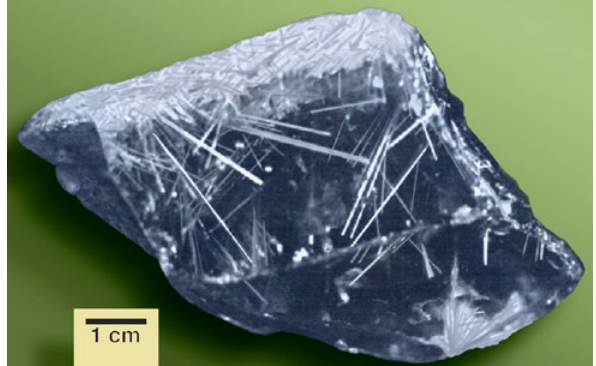
Figure 27. Long slender ‘needles’ of rutile develop in the gelatinous polymeric precursor of a large single crystal of vein quartz. Growth on the small newly nucleated ‘seed crystals’ of rutile in their sup- porting silica gel medium is enhanced in accord with the orien- tation of the crystalline surface with the ‘structure’ or meshwork pattern within the gel. This surface catalysis can therefore be con- fined to one face of the ‘seed crystal’ that grows taking all available dispersed rutile to the exclusion of other